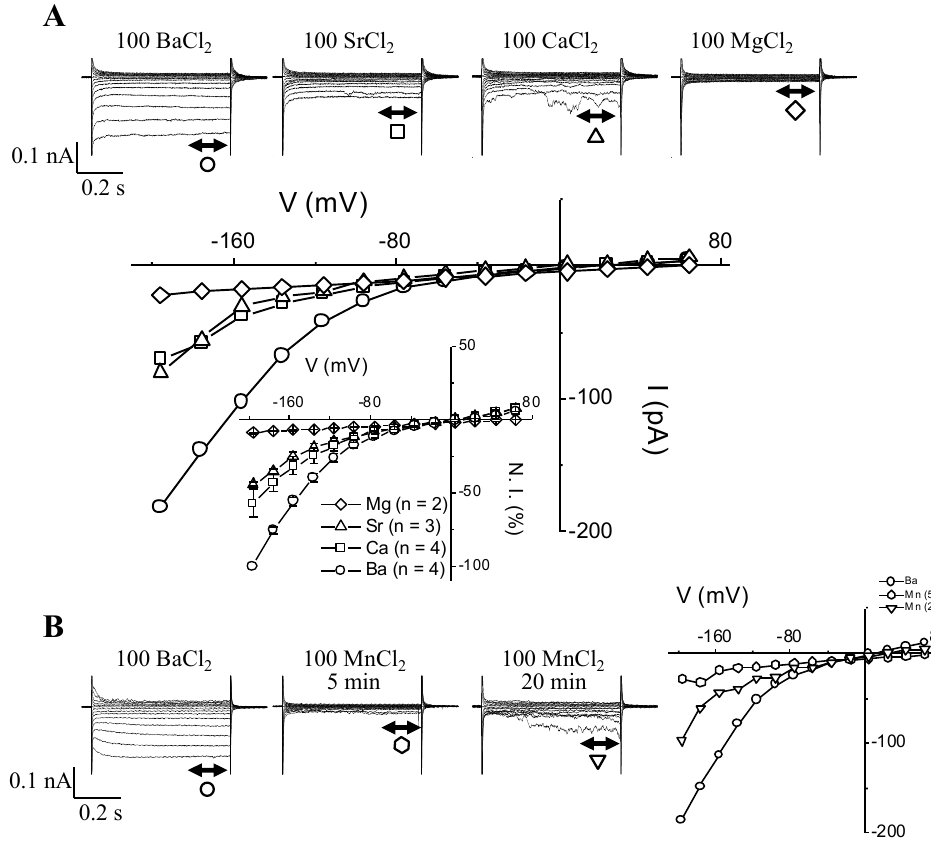
Figure 3. Current through I Ba channels can be carried by other divalent cations, such as Ca 2+ , Sr 2+ , and even Mn 2+ , but not by Mg 2+ . ( A ) Typical current traces and corresponding I-V plots recorded in the presence of 100 mM BaCl 2 , 100 mM CaCl 2 , 100 mM SrCl 2 , and 100 mM MgCl 2 (note that all traces are from the same guard cell except for MgCl 2 ). Inset: Normalized group I-V curves showing divalent permeabilities (the mean current values obtained for Ca 2+ , Sr 2+ , and Mg 2+ were normalized to the mean current value obtained in Ba 2+ at − 196 mV). ( B ) Typical current traces and corresponding I-V plots recorded in the presence of 100 mM BaCl 2 and 100 MnCl 2 at 5 and 20 minutes. All traces are from the same guard cell. Notice the transient blocking effect of Mn 2+ ions.